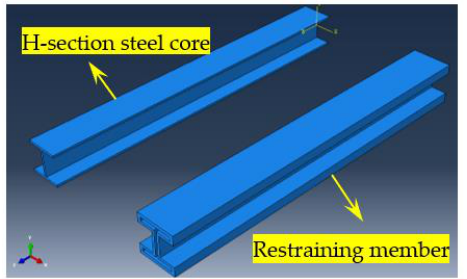
Figure 7. Numerical model for the H-section steel core and restraining member.